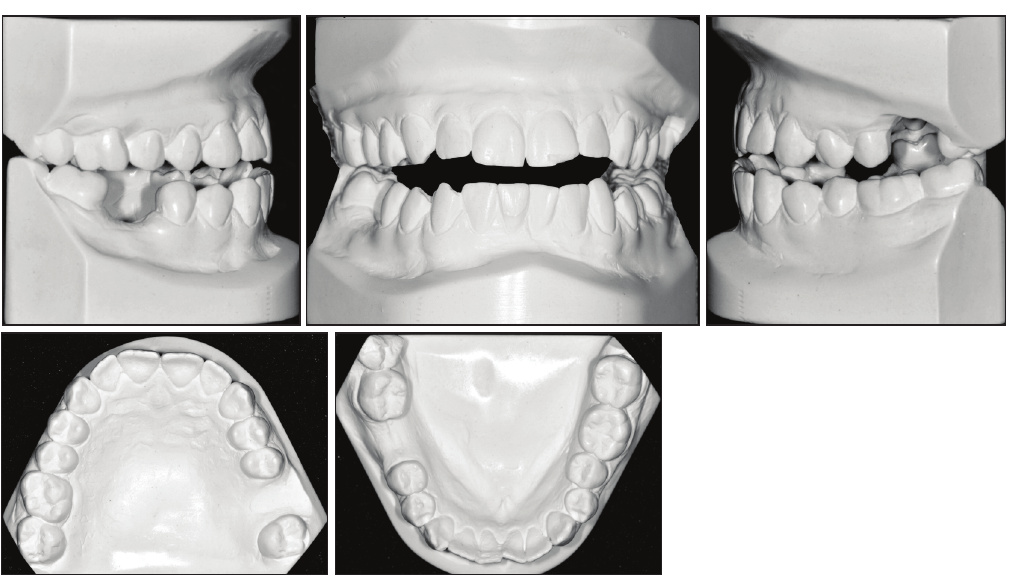
Figure 1. Pretreatment facial and intra-oral photographs.